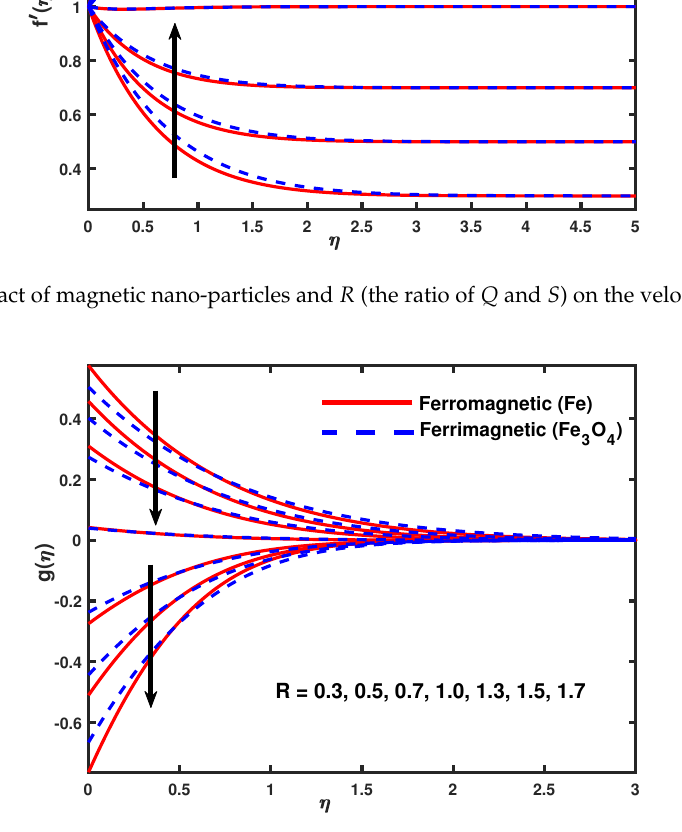
Figure 14. Impact of magnetic nano-particles and R (the ratio of Q and S ) on the micro-rotation velocity g ( η ) . Figure 15 shows the effects of λ on temperature. The increment in λ increases the heat transfer coefficient, which increases the temperature of the ferromagnetic and ferrimagnetic nano-particles